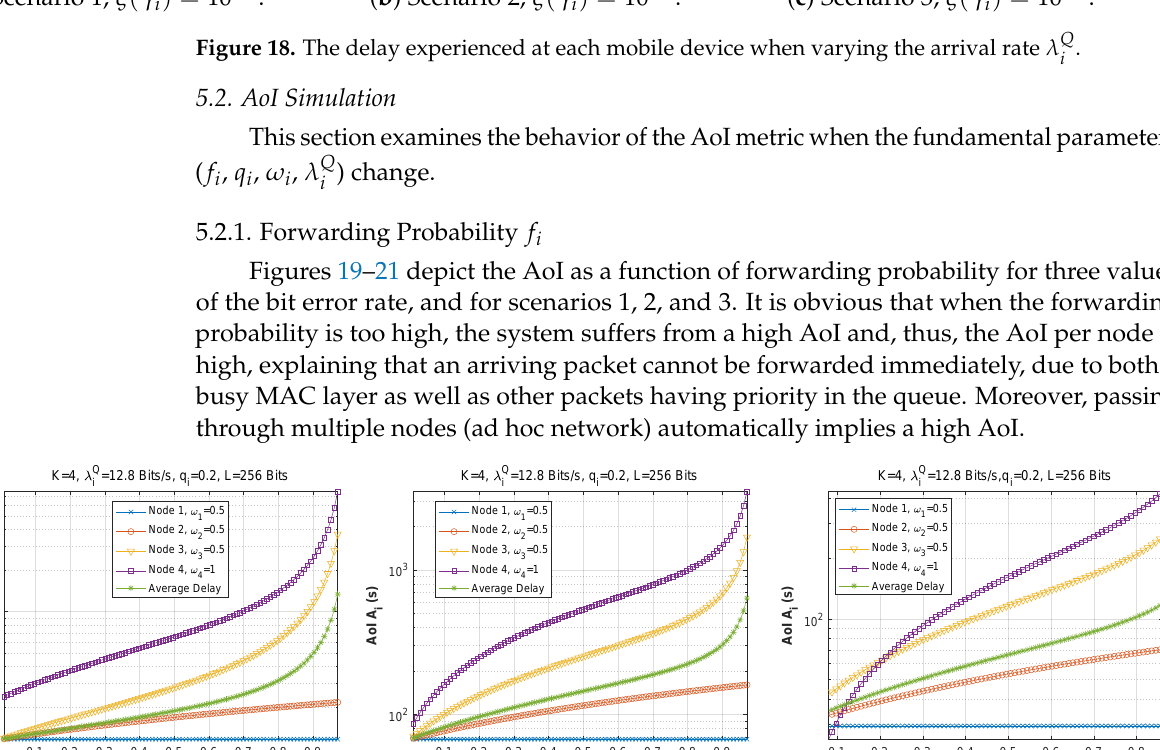
Figure 18. The delay experienced at each mobile device when varying the arrival rate λ Q